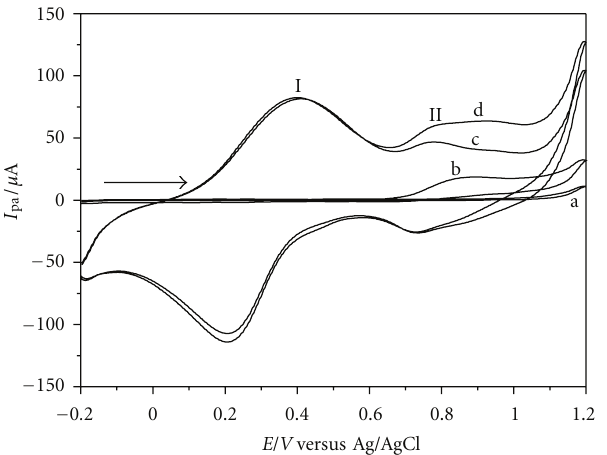
Figure 7: Voltammetric behavior of (a) graphite paste electrode, (b) graphite paste electrode in 1.0 × 10 − 3 molL − 1 nitrite, (c) CuNPSD-modified graphite paste electrode, and (d) CuNPSD- modified graphite paste in the presence of 1.0 × 10 − 3 molL − 1 of